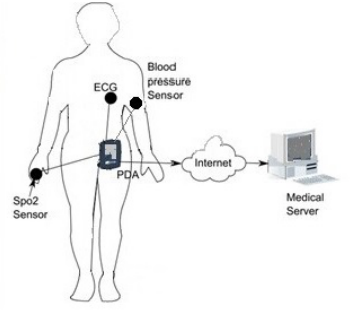
Figure 1. The Architecture of